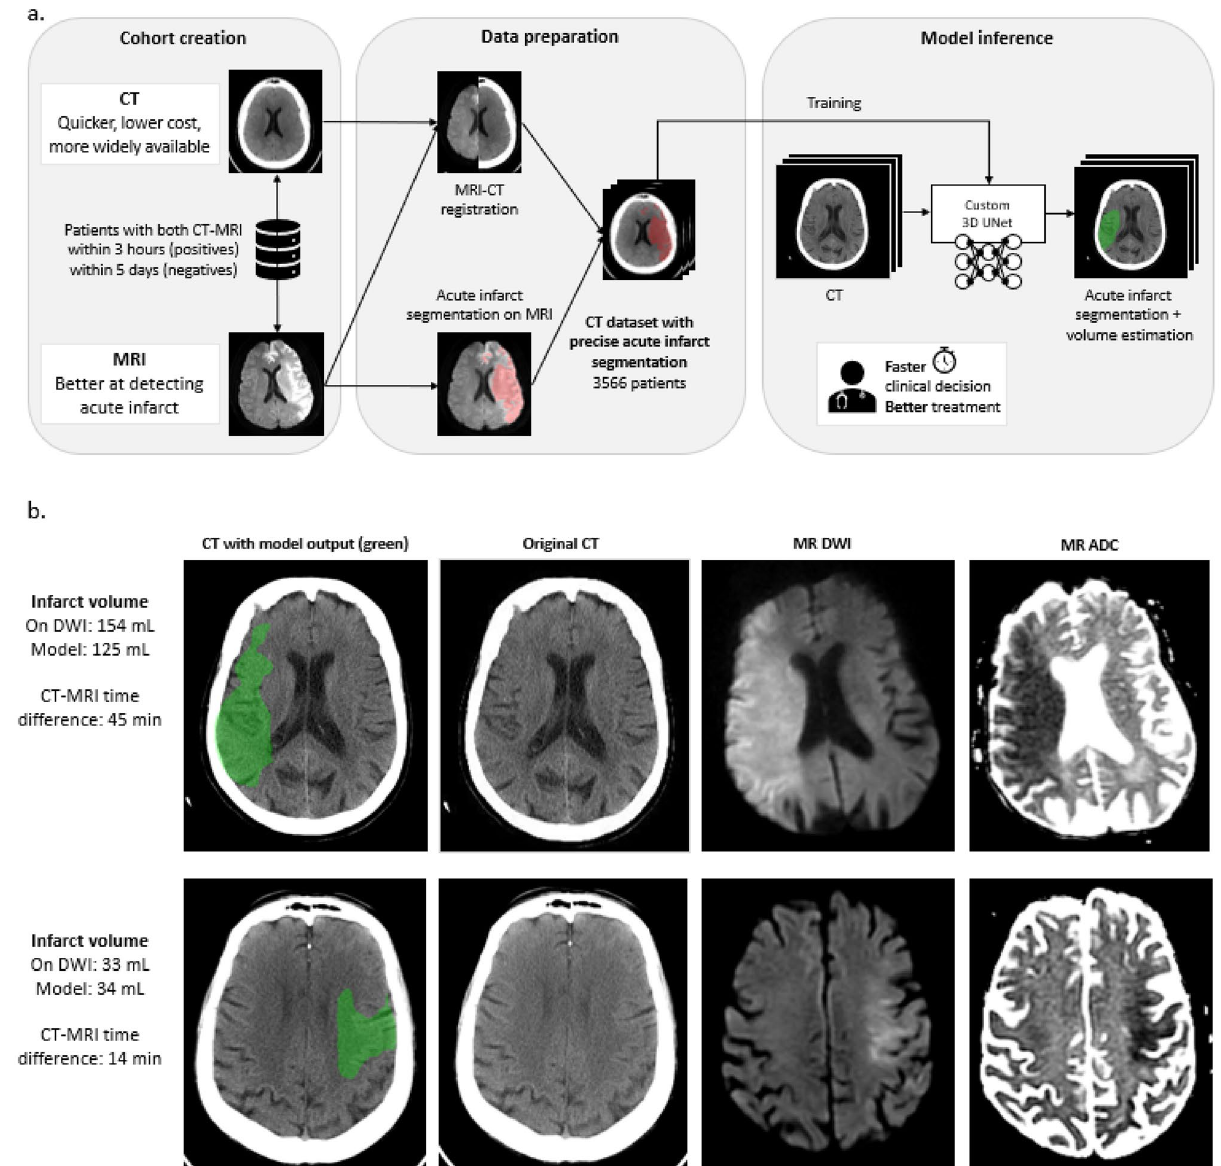
Figure 3. ( a ) Schematic representation of model development steps from cohort creation and data preparation to model inference training. ( b ) Examples of infarcts not detected by each of the three expert neuroradiologists, but accurately detected and delineated by the